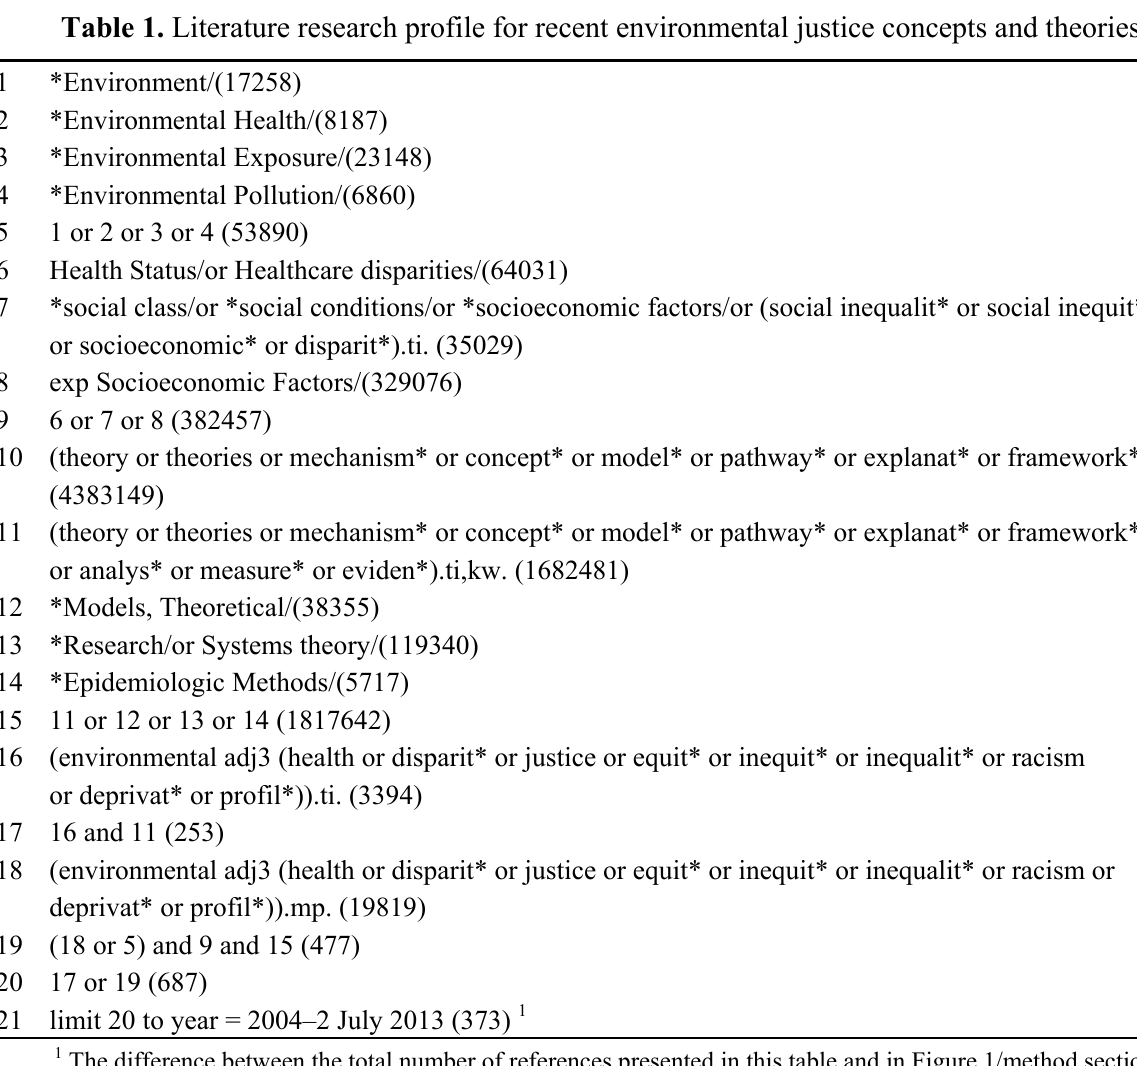
Table 1. Literature research profile for recent environmental justice concepts and